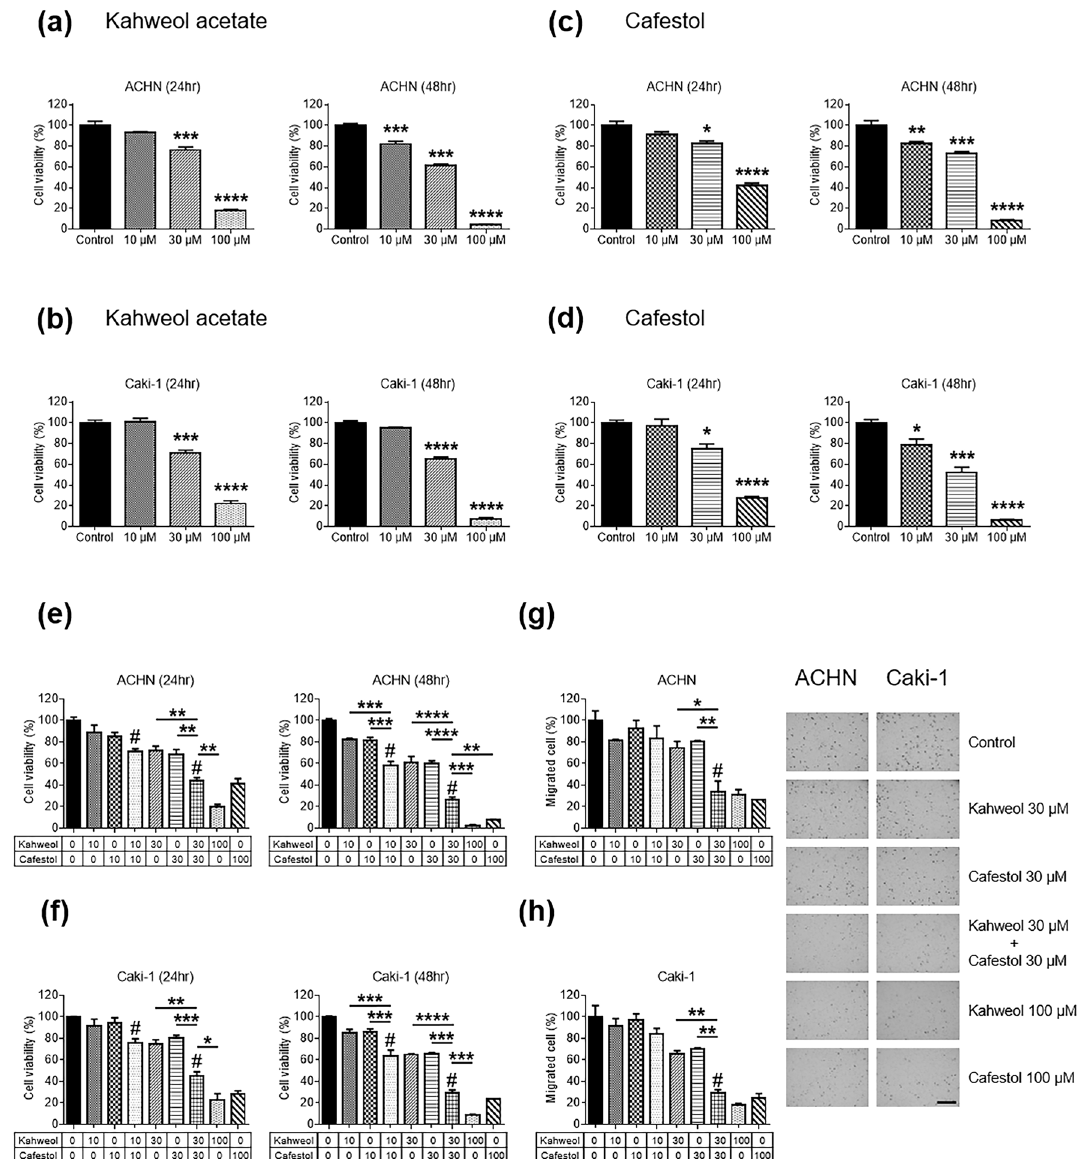
Figure 1. Anti-proliferative and migration effects of kahweol acetate and cafestol on renal cancer cells. ( a – d ) ACHN ( a , c ) and Caki-1 ( b , d ) cells were seeded in 12-well plates (5 × 10 4 cells/well) with RPMI containing 10% FBS. Each cell was treated with or without pre-determined concentrations of kahweol acetate and cafestol for 24 and 48 h. ( e , f ) Anti-proliferative effects of the combination of kahweol acetate and cafestol on ACHN ( e ) and Caki-1 ( f ) cells for 24 and 48 h. ( g , h ) Anti-migration effect of the combination of kahweol acetate and cafestol on ACHN ( g ) and Caki-1 ( h ) cells for 12 h. Bar = 500 µm. All experiments were performed in triplicate. Data are presented as means ± standard error of the mean. * p < 0.05; ** p < 0.01; *** p < 0.001; **** p < 0.0001. # Synergistic effects were